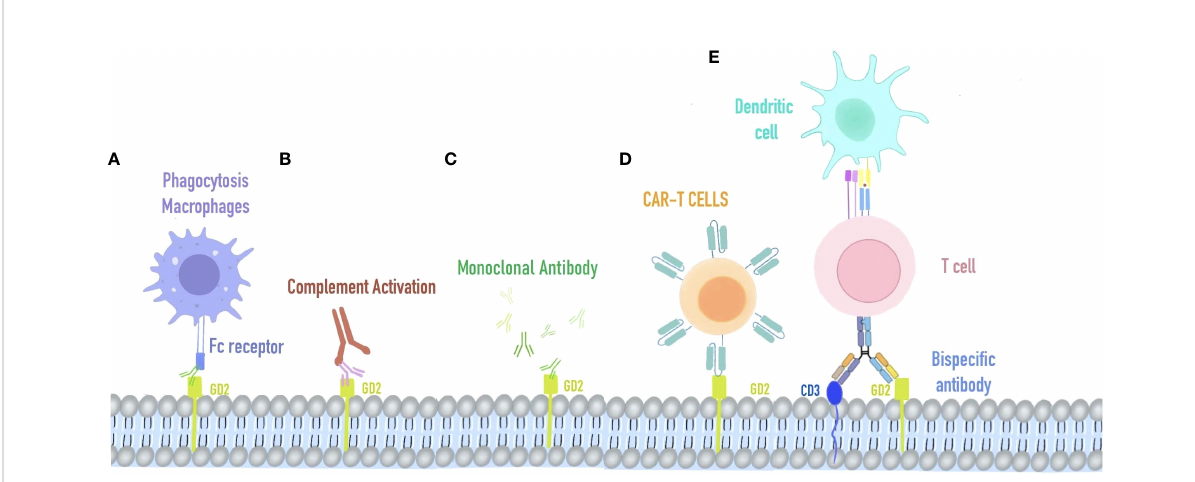
FIGURE 1 Immunotherapy strategy targeting GD2. (A) Macrophage phagocytosis combined with retinoblastoma cells mediated by anti-GD2 Fc receptors. (B) Complement activation on GD2-expressing retinoblastoma. (C) AntiGD2 monoclonal antibody is used for high-risk retinoblastoma. (D) CAR- T cells recognize retinoblastoma cells via their speci fi c T cell receptors against GD2. (E) Bispeci fi c antibody of GD2 and CD3, redirecting T cells and accessory immune cells (via their functioning Fc-fragment) toward retinoblastoma